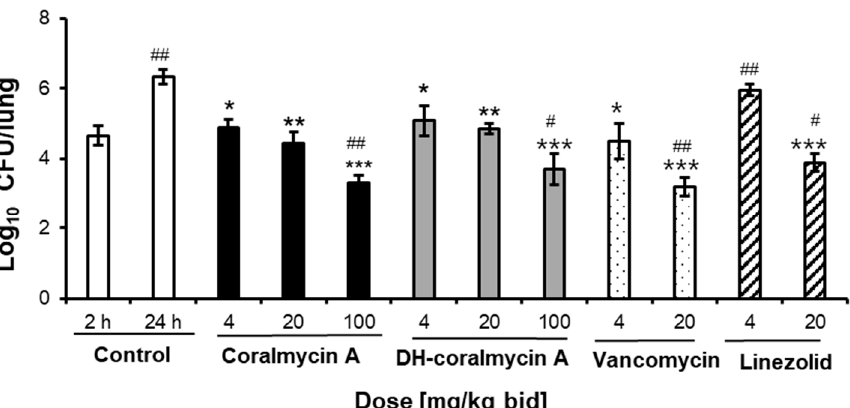
Figure 4. Therapeutic efficacies of coralmycins in a mouse model of respiratory tract infection caused by S. pneumoniae ATCC49619. The MIC values of coralmycin A, DH-coralmycin A, vancomycin, and linezolid against S. pneumoniae ATCC49619 were 0.01, 0.25, 0.5, and 2 mg/L, respectively. CFU in the lungs (n = 4) of vehicle- and drug-treated mice were determined. The experiment shown is representative of two independent trials. Data are expressed as the mean ± SD (n = 4; * p < 0.05, ** p < 0.01, and *** p < 0.001 versus 24 h control; # p < 0.05 and ## p < 0.01 versus 2 h control). p values were obtained using unpaired Student’s t